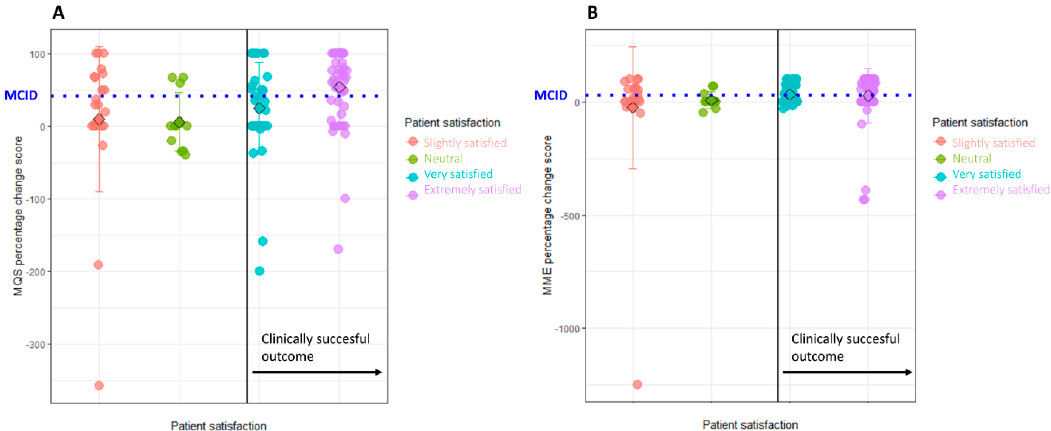
Figure 2. Scatterplot of MQS ( A) and morphine milligram equivalent (MME) ( B ) percentage change score between baseline and 12-month follow-up, separated according to patient satisfaction. The colours represent the different levels of patient satisfaction. Levels on the right side of the solid black line are considered clinically successful and categorised as “better”. On the y -axis, percentage scores between baseline and 12-month follow-up are presented, which were calculated as follows: ((baseline score − follow-up score)/baseline score) × 100). Positive scores indicate an improvement at follow-up compared to baseline, while negative percentages indicate a worse outcome at follow-up compared to baseline. MCID values were calculated and are presented on the plot by the dashed blue lines. For MQS, the MCID is located at 41.18% and for the MME at 28.20%. Abbreviations. MME: morphine milligram equivalents ; MQS: Medication Quantification Scale III.